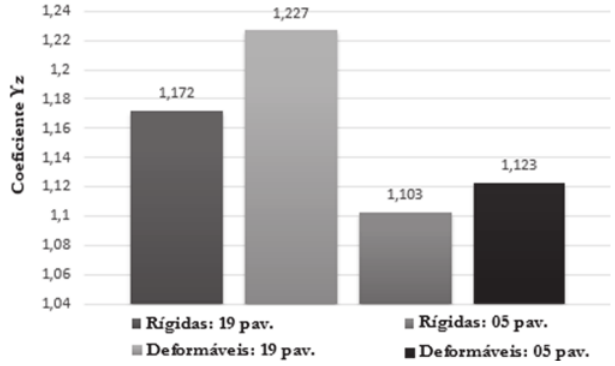
Figura 16 Modelo de Alva e El Debs [21]: coeficiente